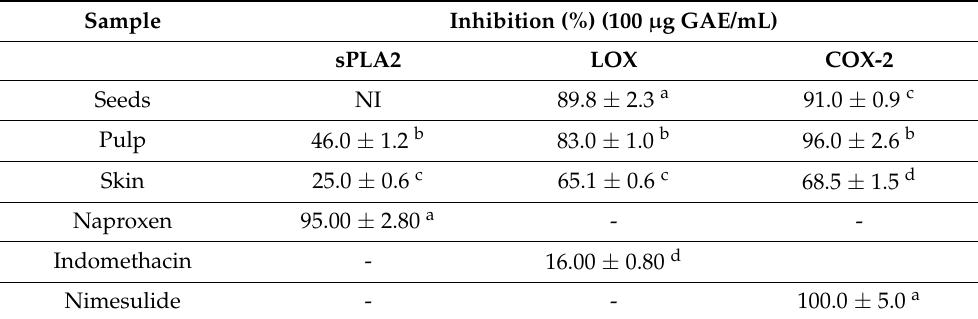
Table 1. Inhibitory activity of pro-inflammatory enzymes by extracts (PEE) of Z. mistol